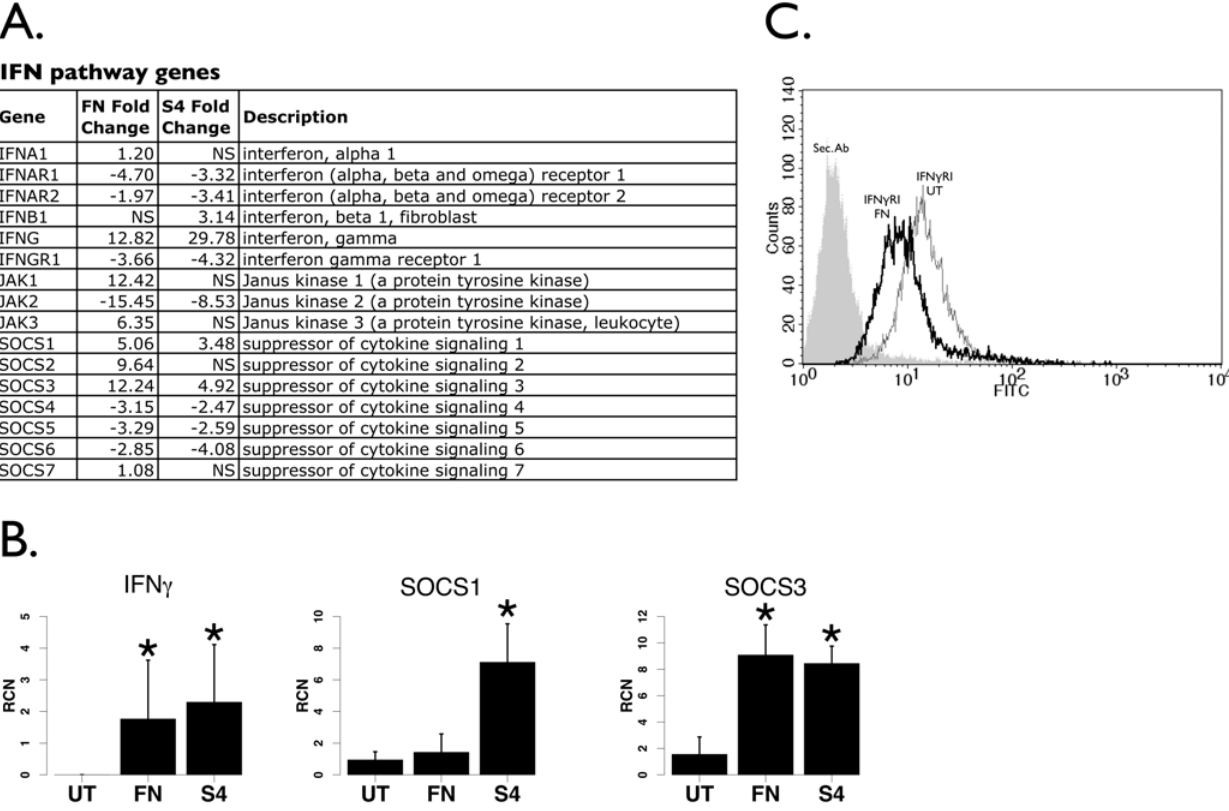
Figure 2. Francisella -induced changes in IFN c pathway-related genes. A. List of IFN, Jak and SOCS genes regulated by Francisella infection (both F. novicida and Schu S4) from the microarray analysis. Fold changes of genes not statistically different are denoted ‘‘NS’’. B. Real-time PCR of IFN c , SOCS1 and SOCS3 from human PBM infected with either F. novicida (‘‘FN’’) or Schu S4 (‘‘S4’’) at 100 MOI for 24 hours (n=8). ‘‘RCN’’ is Relative Copy Number for the Y axis. Asterisks denote statistical significance (p # 0.05) versus uninfected. C. Flow cytometry for the IFN c receptor following F. novicida infection of human monocytes. The data are representative of three independent experiments.